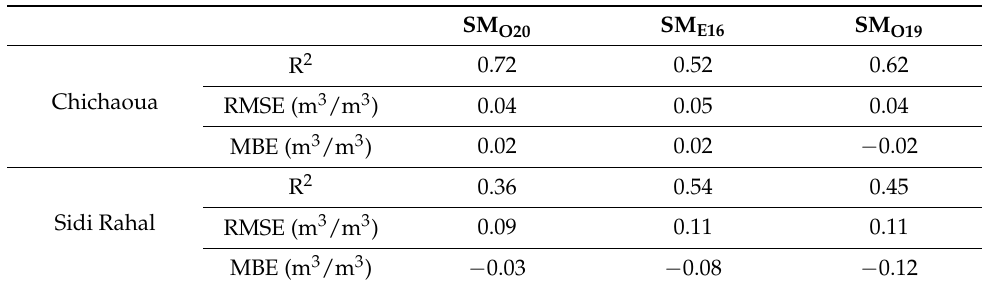
Table 1. Statistical parameters for validation results of satellite retrieved soil moisture (SM) at the Chichaoua and Sidi Rahal sites.